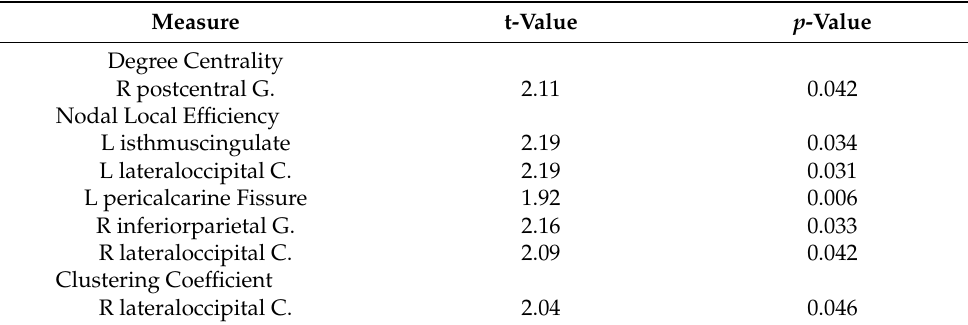
Table 2. Graph–theoretic results where all results denote ADHD >